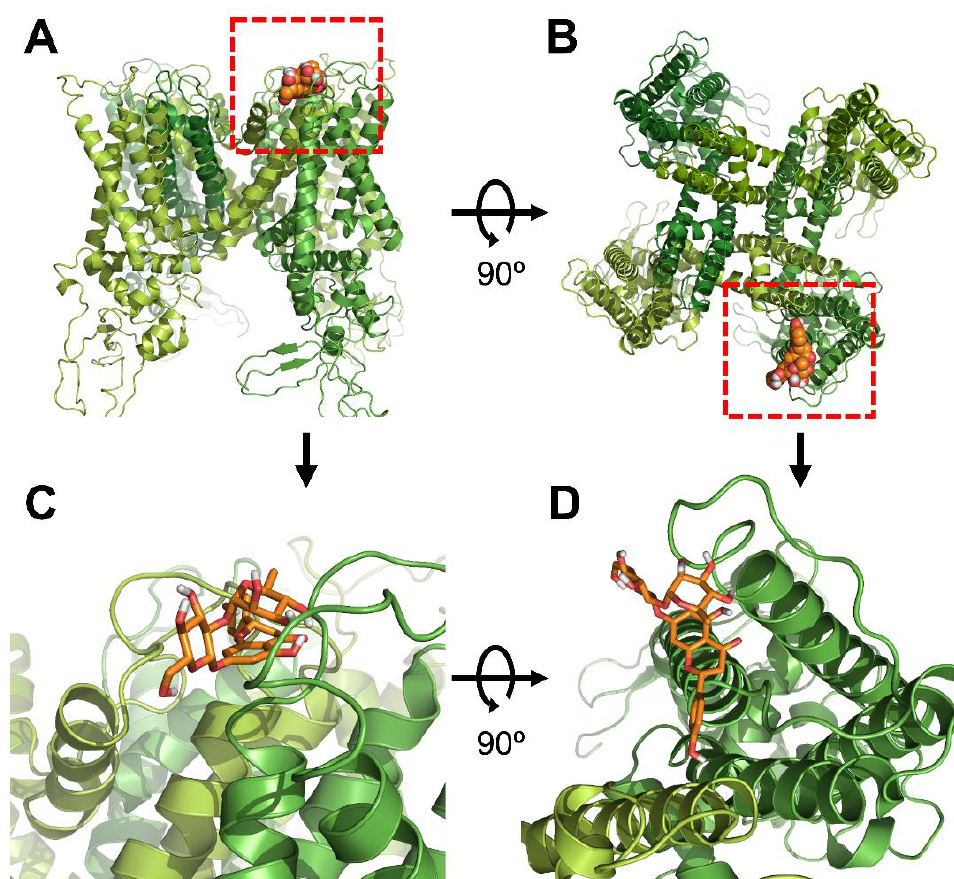
Figure 4. Molecular docking modeling of naringin to TRPV1: ( A ) side views of the docked naringin in complex with TRPV1. ( B ) Top views of the docking model. ( C ) An enlarged view of the red dotted line in Figure 4A. ( D ) An enlarged view of the red dotted line in Figure 4B.